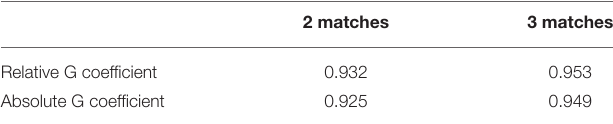
TABLE 4 | Evolution of G coefficients as a function of the number of matches to be